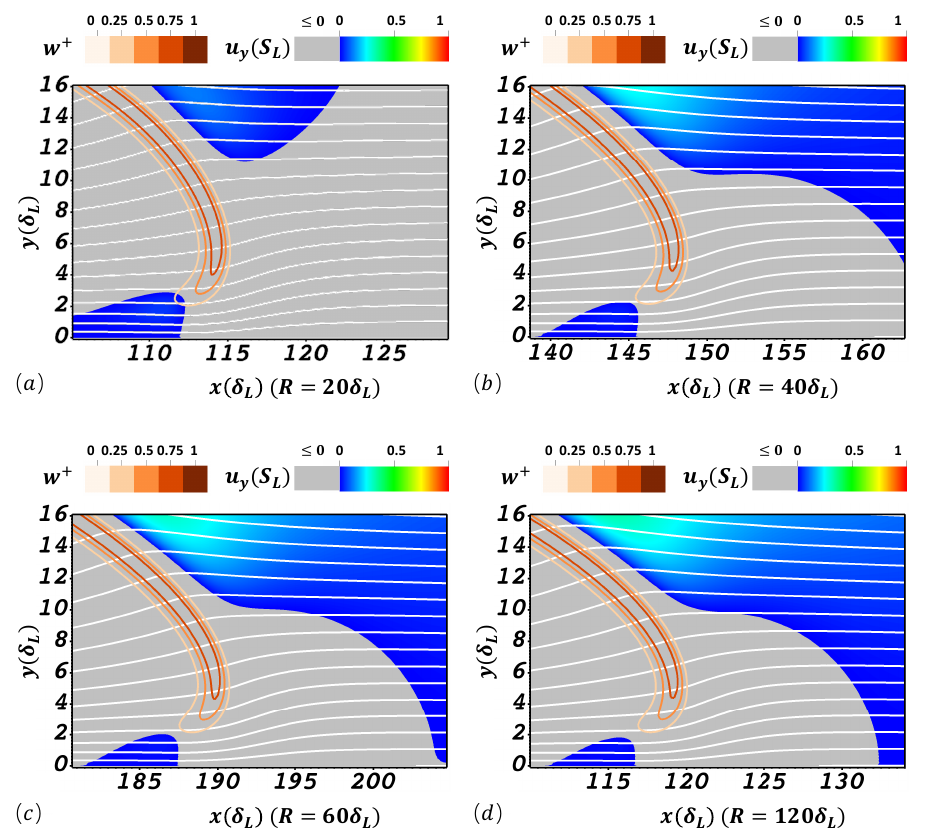
Figure 8. Flame shapes (based on the reaction rate isolines) and streamlines for different channel widths at the critical condition, θ = 4. Subplots ( a – d ) are for R = 20,40,60,120 δ L respectively. The normalized reaction rate is illustrated by the contour lines. Pseudo-color field shows the vertical component of the velocity u y . u y ≤ 0 is highlighted in